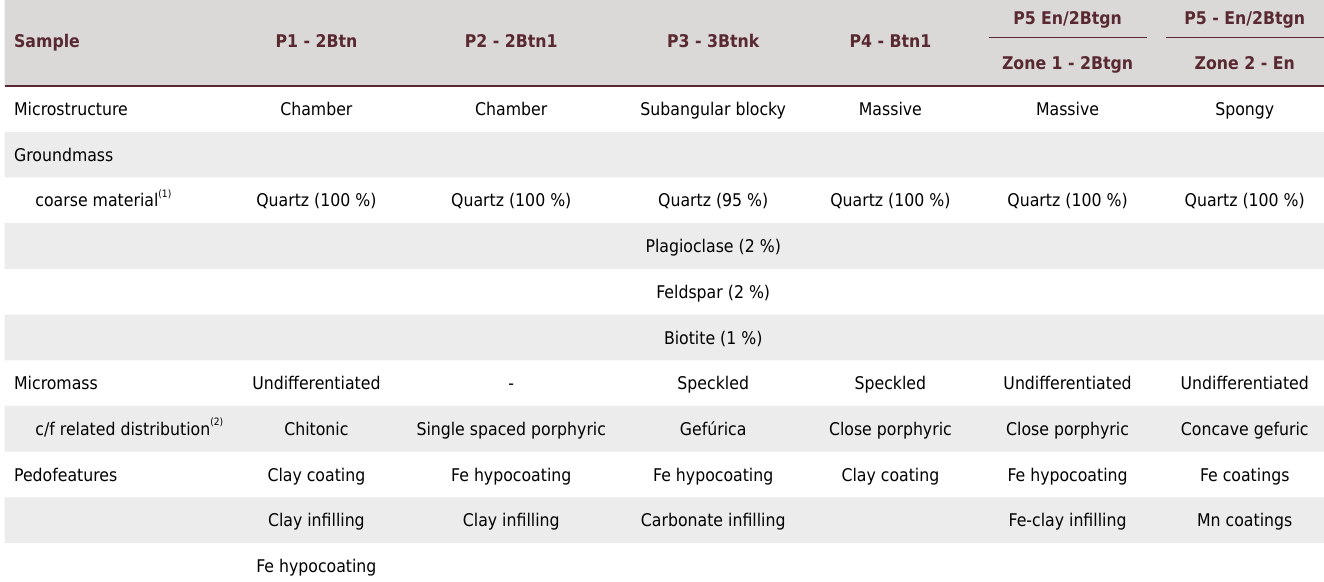
Table 5. Description of the thin section, according to Bullock et al. (1985) and Stoops (2003)